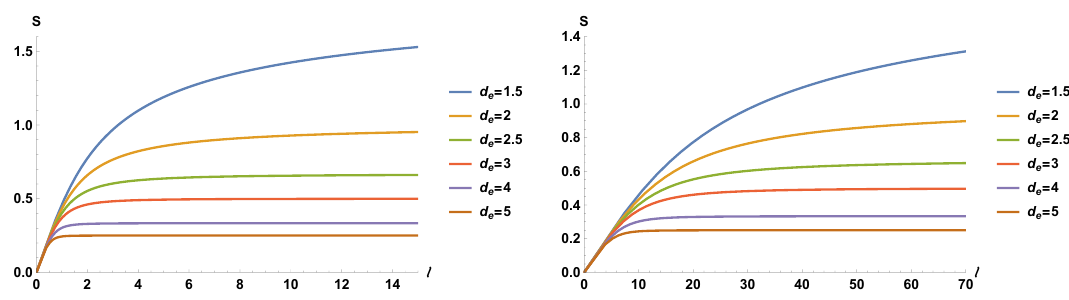
Figure 3 . HEE as a function of ‘ for different values of the cutoff: Left ) r c = 1 Right ) r c = 10 . Here we set R = 1 and renormalized S as ˜ S = r de − 1 c S